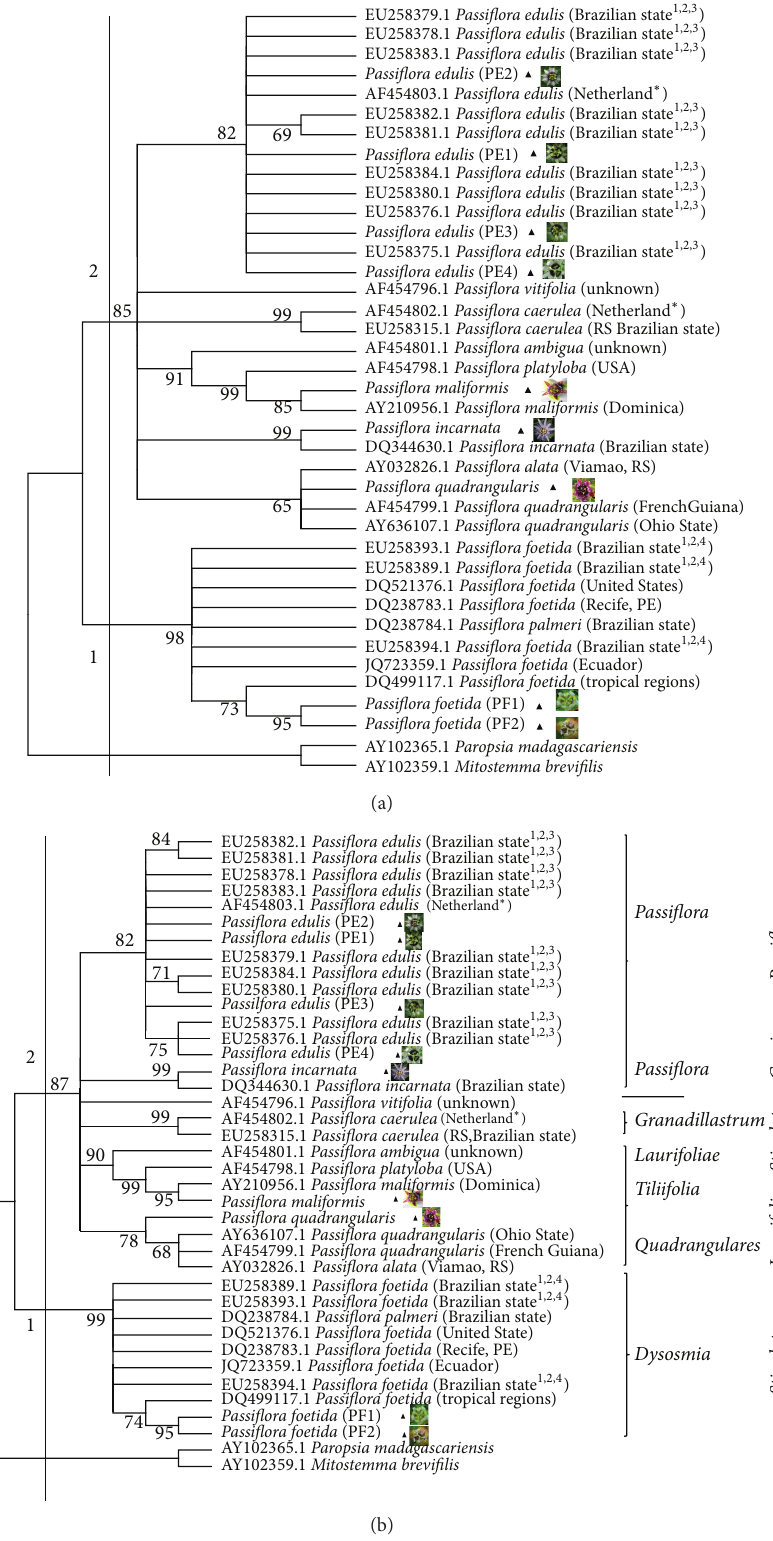
Figure 2: (a) Phylogenetic tree of Passiflora accessions inferred from the ML analysis using the Tamura three-parameter model. Only bootstrap scores greater than 60% are shown. Mitostemma brevifilis and Paropsia madagascariensis were used as outgroups. (b) Phylogenetic tree of Passiflora accessions inferred from parsimony analysis (full heuristic search with the tree bisection reconnection